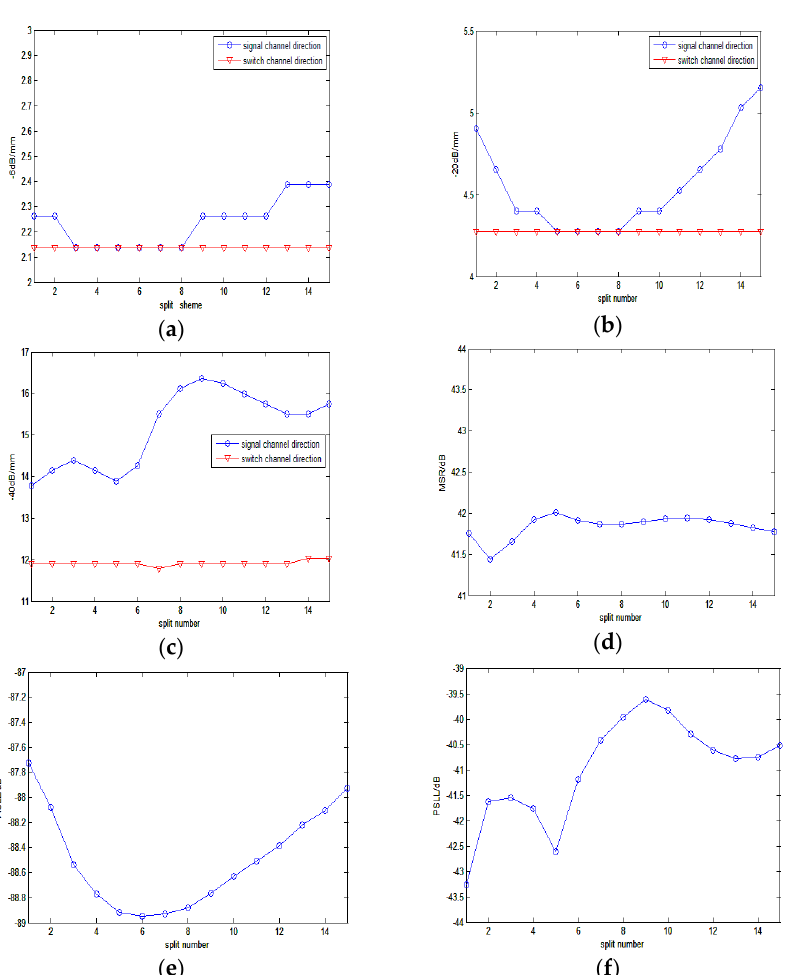
Figure 5. The measured parameters for different schemes. ( a – f ) represent the − 6 dB, − 20 dB, − 40 dB main-lobe widths, MSR, ASLL, and PSLL vs split scheme, respectively, where the red lines and the blue lines in ( a ), ( b , c ) represent the − 6 dB, − 20 dB and − 40 dB main lobe widths curves in switch channel direction and in signal channel direction, respectively.